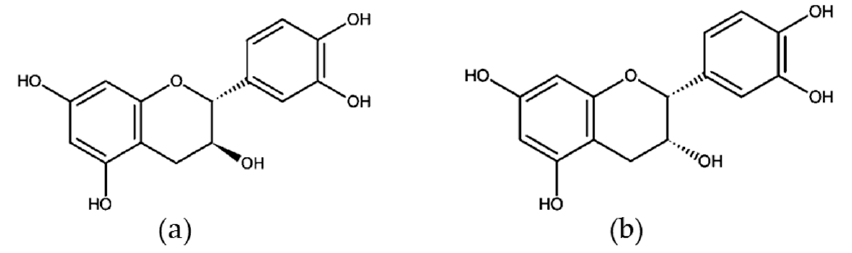
Figure 3. Structures of ( a ) (+)-catechin and ( b ) (-)-epicatechin.